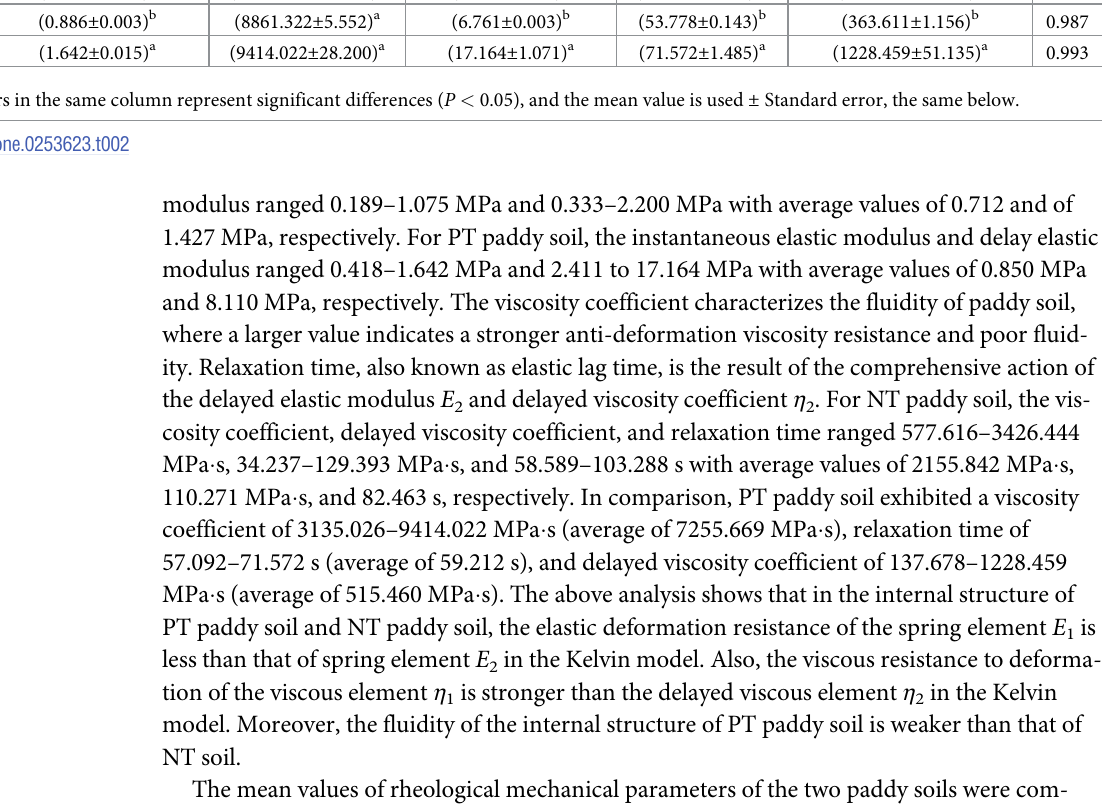
Note: Different lowercase letters in the same column represent significant differences ( P < 0.05), and the mean value is used ± Standard error, the same